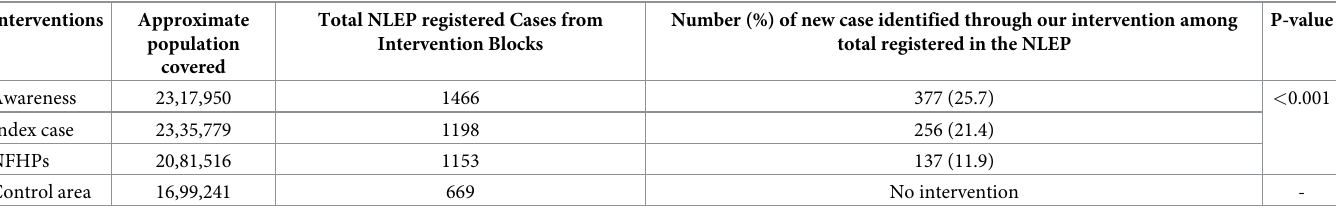
Table 2. Summary of number of new cases identified through our interventions among new cases registered in NLEP during the intervention period. Interventions